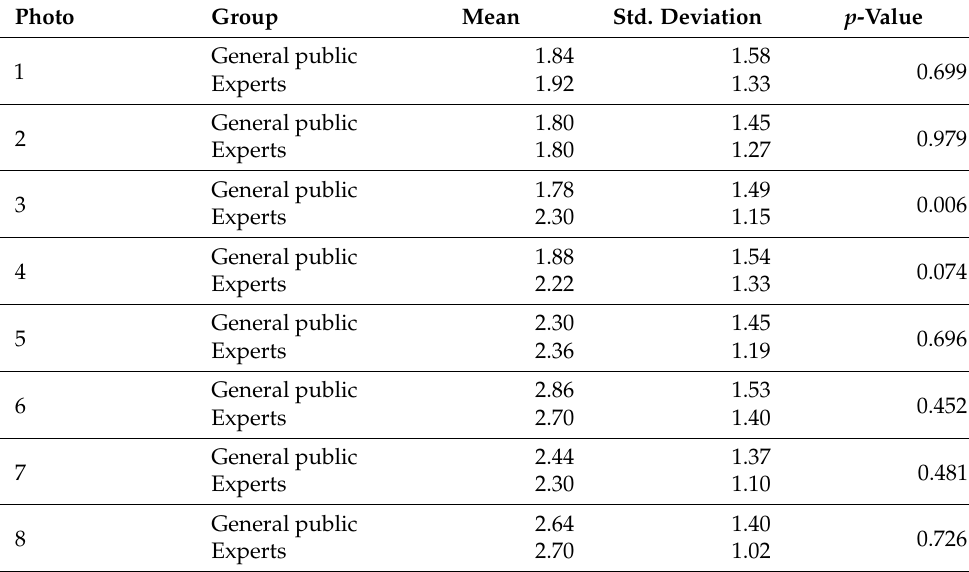
Table 14. Evaluation of creation of light reflections by experts and the